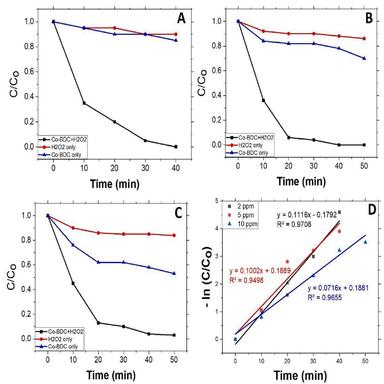
MB Degradation time profile for the different initial concentrations. (0.05 g catalyst, 0.5 mM H2O2): (A) 2, (B) 5, (C) 10 ppm, and (D) pseudo-first-order plots of MB degradation by Co-BDC/H2O2 system for different MB initial concentrations.